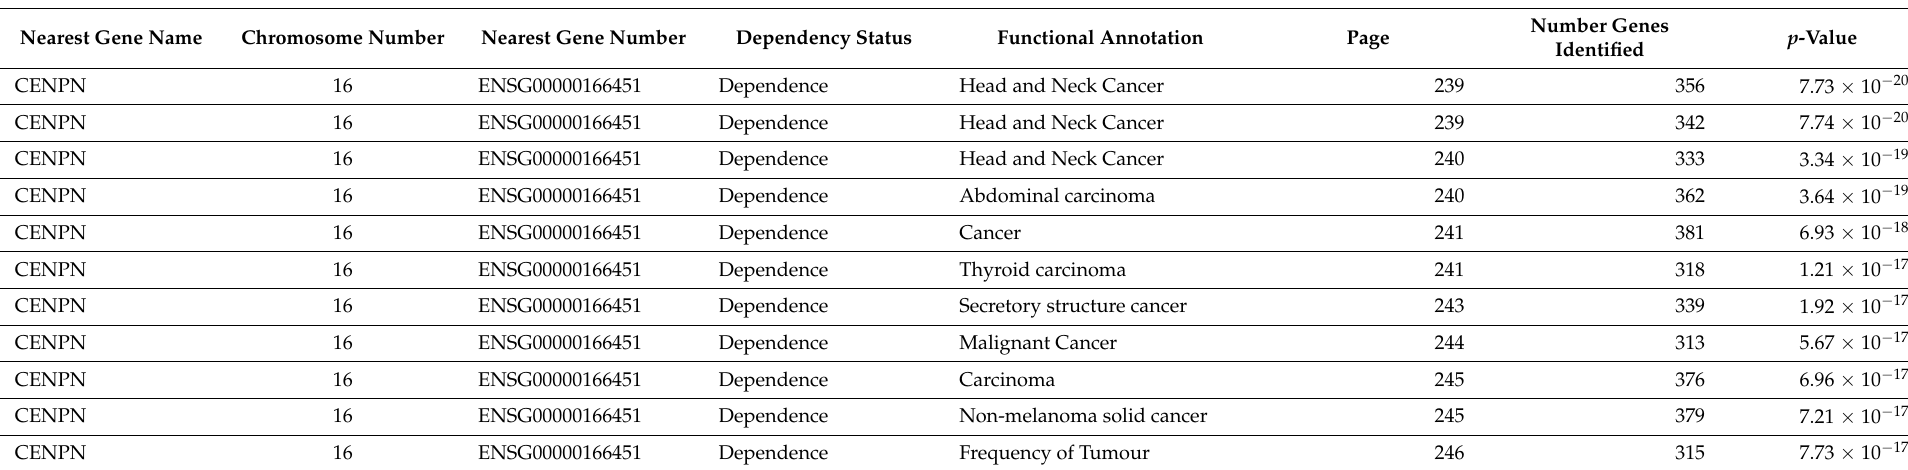
Table 12. Selected EWAS Hits on Centromere Protein N (CENPN); Data from Schrott